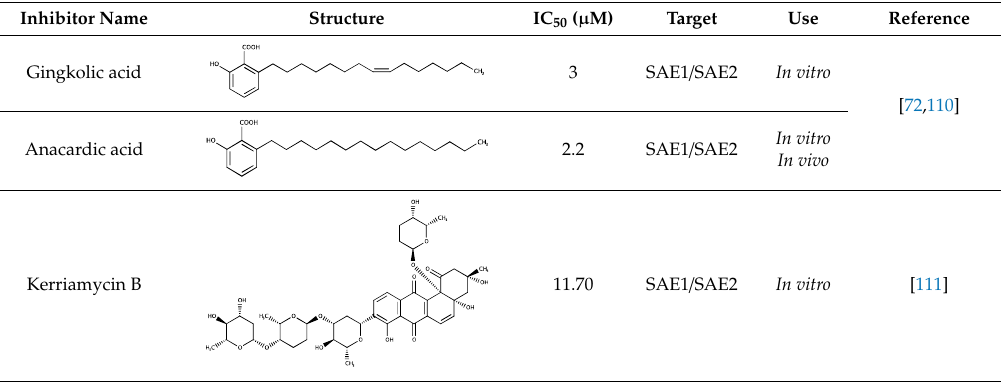
Figure 5 . Role of SUMOylation in the regulation of Tax oncoprotein of the human T-cell lymphotropic virus type I (HTLV1) virus. Upon As 2 O 3 and INF  treatment, Tax is recruited to PML NBs. It is then poly-SUMOylated, recognized by RNF4, poly-ubiquitylated, and degraded by the proteasome.